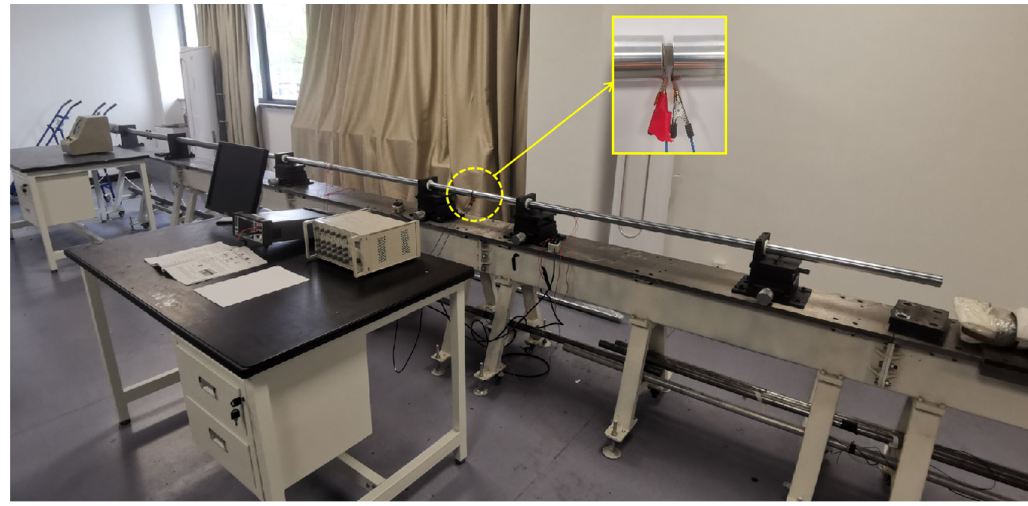
Figure 2. SHPB experimental setup.